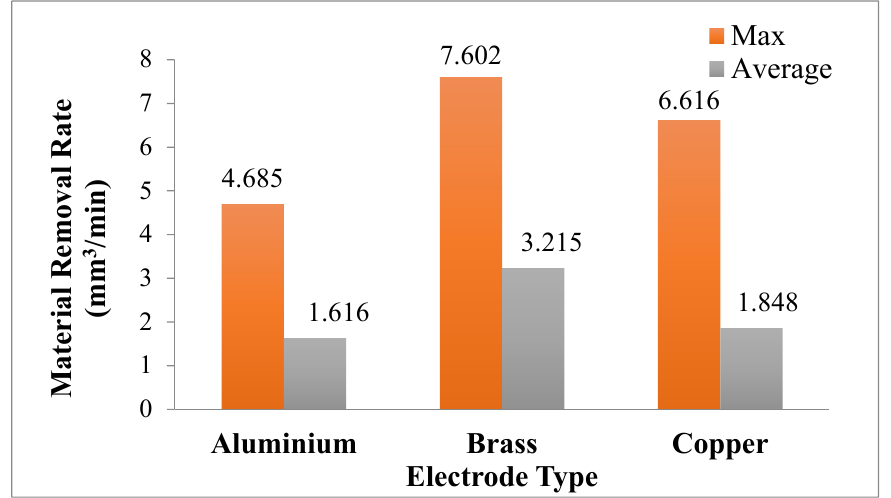
Figure 9. Comparison of three electrodes with MRR in graphene-mixed dielectric.